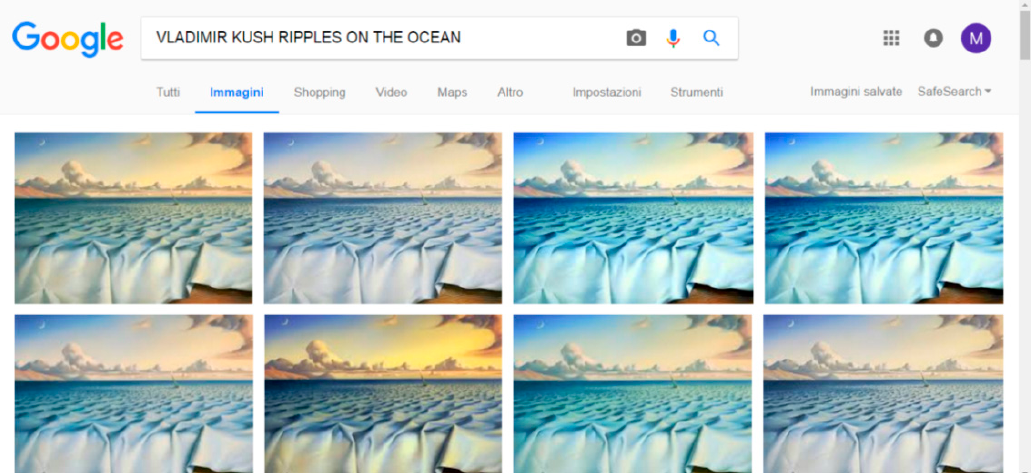
Figure 1. Search for images on the Net. Painting by Vladimir Kush “Ripples on the ocean”. Courtesy of the author. ©Kush Fine Arts limited